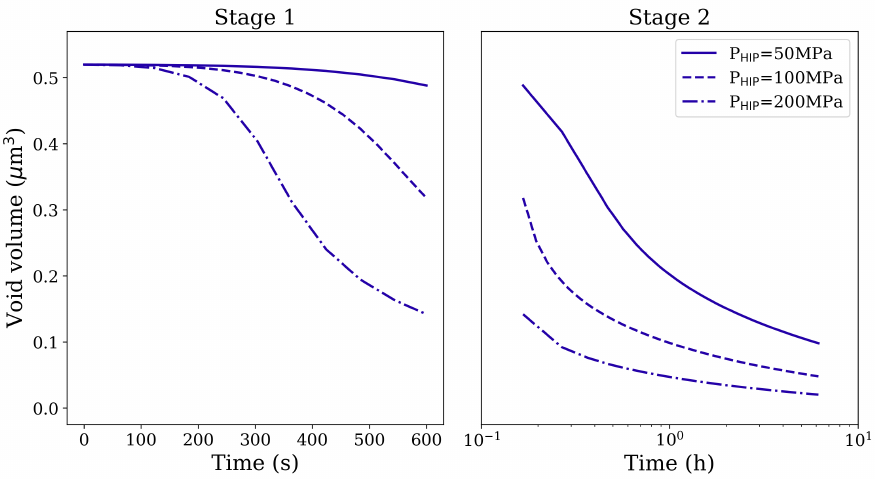
Figure 5. Void volume reduction in Stage 1 and Stage 2 HIP loading for spherical void of radius 1 µ m under different magnitudes of the isostatic pressure and different holding times at 1561